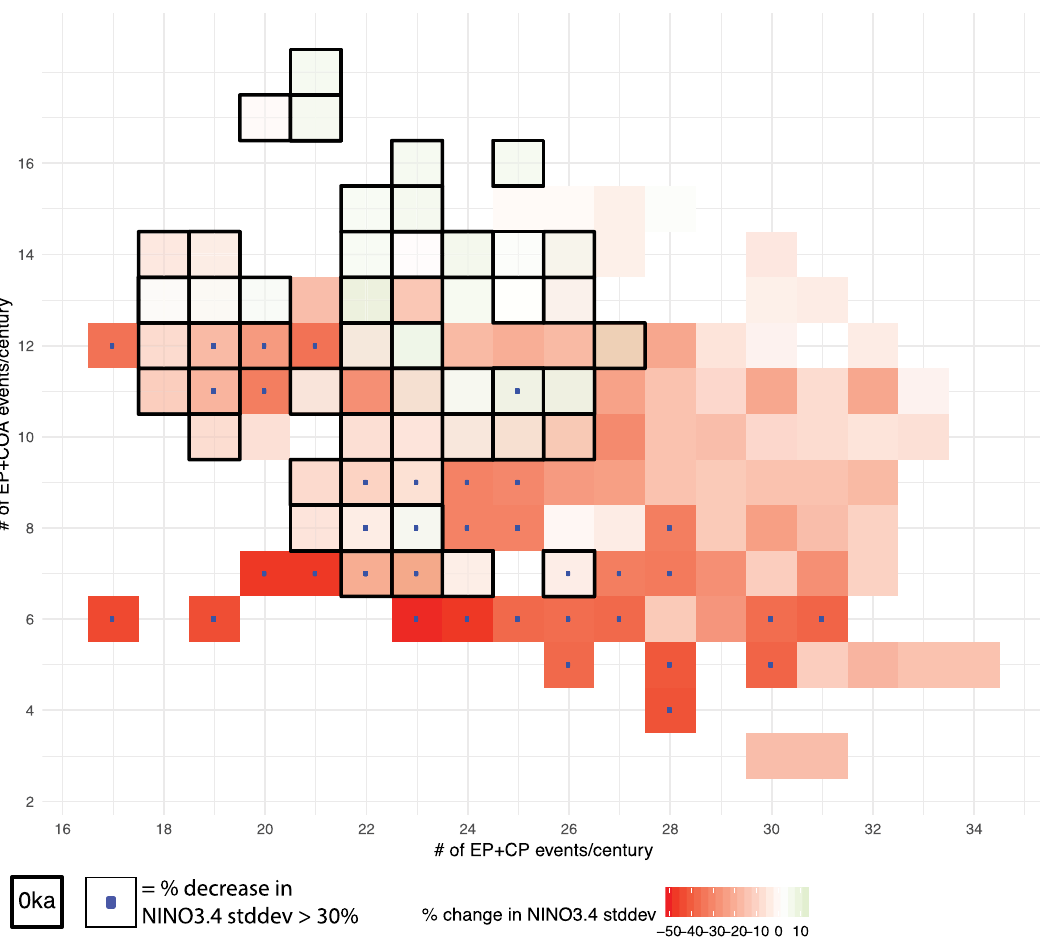
Fig. 4 | Simulated relative changes in El Niño-Southern Oscillation (ENSO) fl a- vors in the Holocene. Number of “ eastern Paci fi c in fl uence ” events (Eastern Paci fi c (EP) + Coastal (COA); ordinate) vs number of “ central Paci fi c in fl uence ” events (Eastern Paci fi c (EP) + Central Paci fi c (CP); abscissa) in time-slice Holocene experi- mentswiththeCommunityEarthSystemModelv1(CESM1).Eachtilerepresents100 yrsamplesto accountforinternalvariability.Colored shadingshowsthe percentage change in the standard deviation of NINO3.4 SST anomalies compared to the pre-